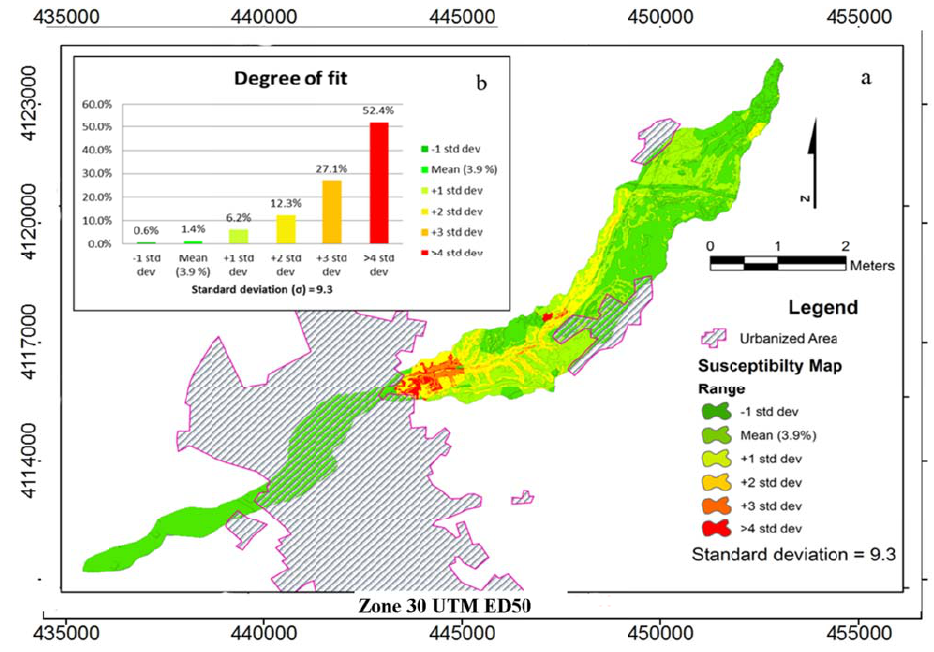
Fig. 7. Landslide susceptibility map (a) and validation (b) . Coordinate Reference System: UTM zone 30 European Datum Fig. 7 – L Landslide suusceptibilityy map (a) an